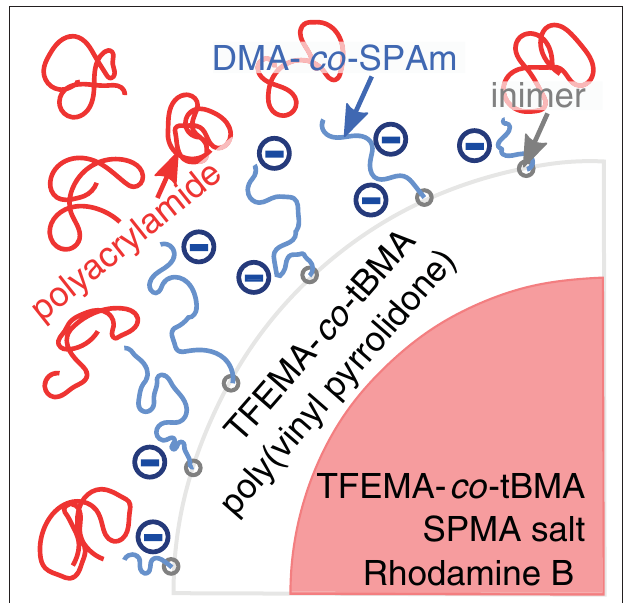
FIGURE 1 | Illustration of the depletion model system. Copolymer core-shell particles were stabilized in aqueous solvents by short charged polymer chains. Addition of polyacrylamide to the solution induced a depletion attraction between the particles. DMA, N,N-dimethylacrylamide; SPAm, 2-acrylamido-2-methyl-1-propanesulfonic acid; inimer, 2-(2-bromoisobutyryloxy) ethyl acrylate; SPMA salt, 3-sulfopropyl methacrylate potassium salt.